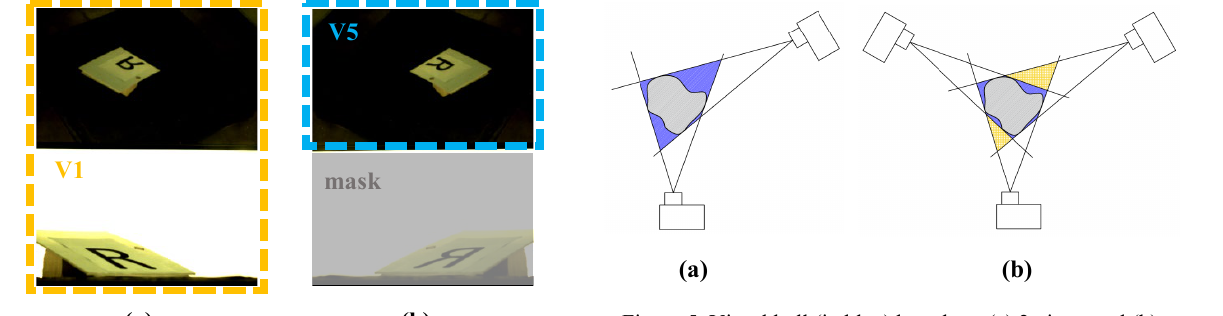
Figure 5. Visual hull (in blue) based on: (a) 2 views and (b) 3